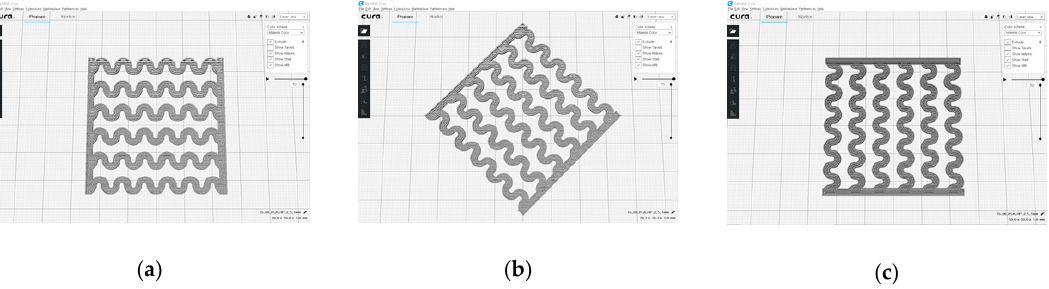
Figure 2. 3D modeling of horseshoe patterns with different printing directions among ( a ) 0°, ( b ) 45°, and ( c ) 90°.